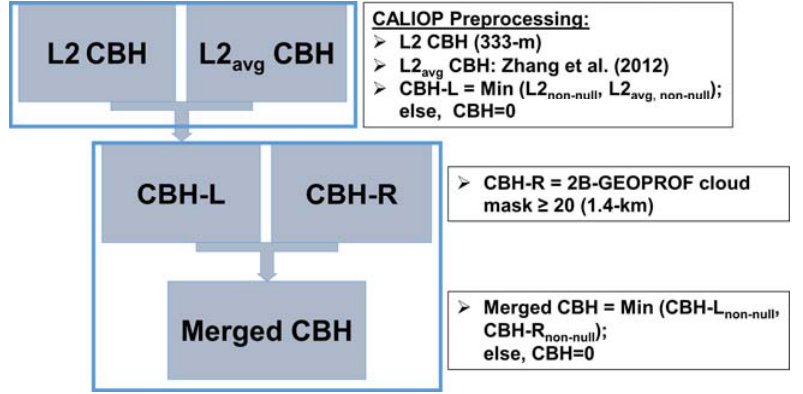
Figure 2. Schematic of merging the CALIOP cloud base height (CBH) using the L2 333-m cloud layer product and the Cloud Profiling Radar (CPR) CBH from the geometrical profile product (2B-GEOPROF).